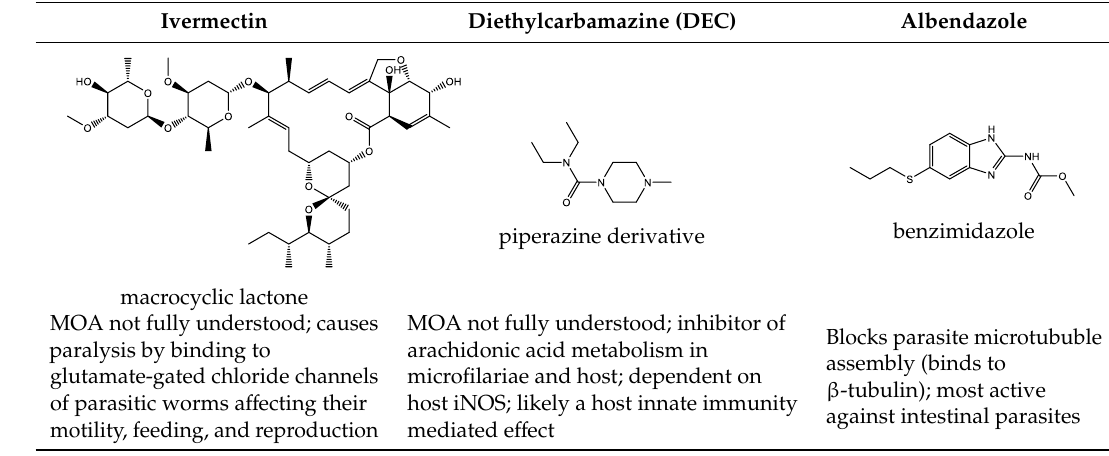
Table 2. Antifilarial parasitic drugs.